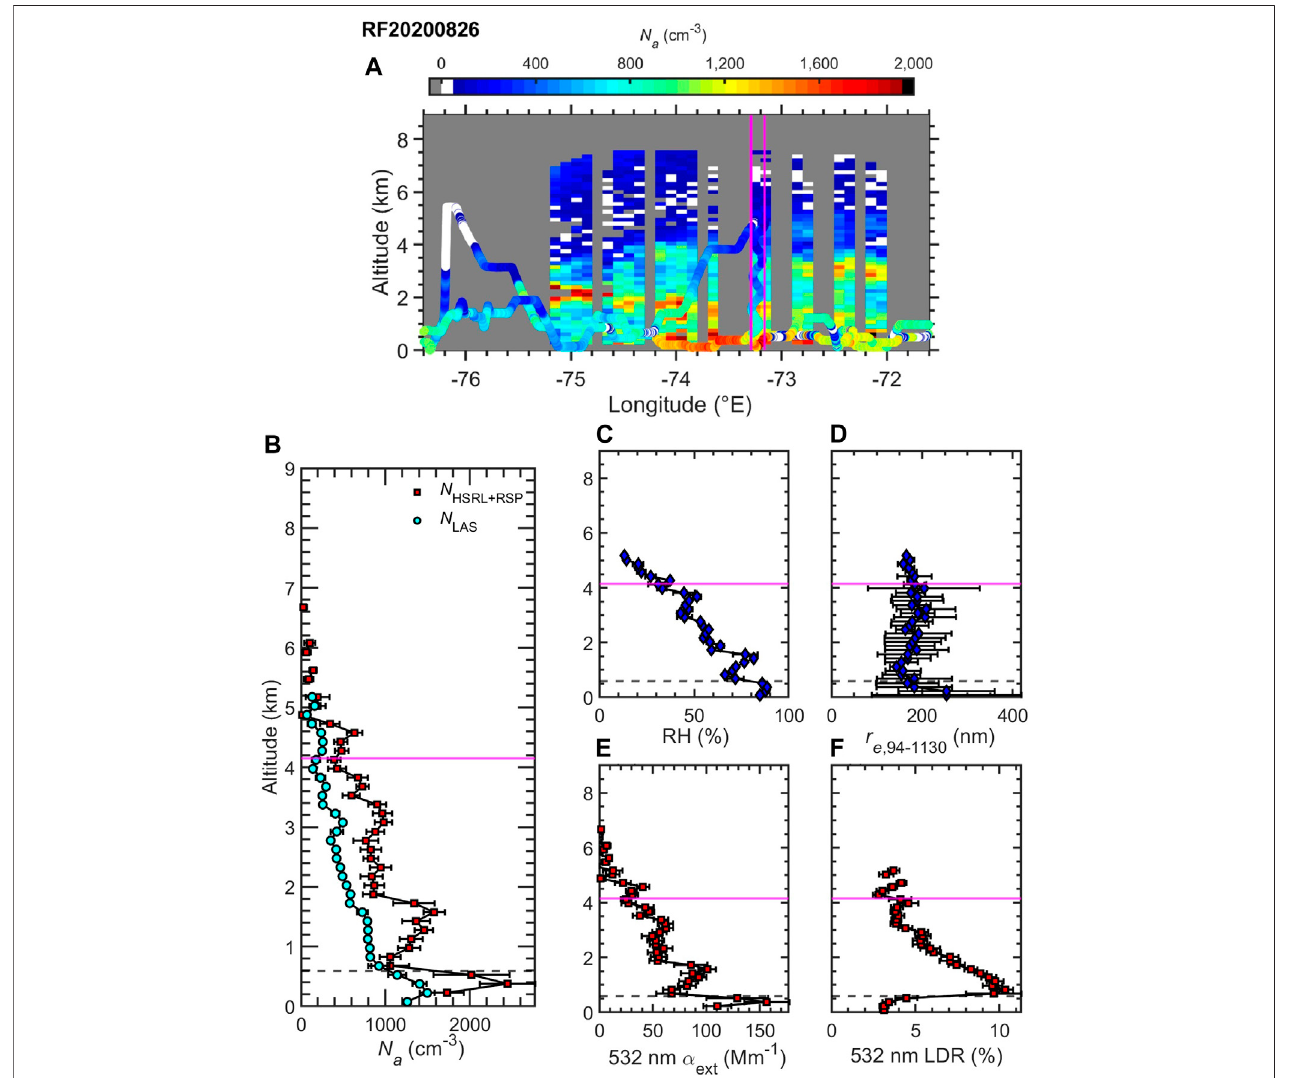
FIGURE 3 | Horizontal curtain (A) and vertical pro fi les (B – F) of remote sensing and in situ data gathered from the ‘ optimal ’ fl ight that occurred on 26 August 2020. The vertical pro fi les were taken from the in situ pro fi le that occurred between 15:46:25 and 15:58:12 (UTC) on 26 August 2020. Panel (A) shows the fl ight track and surface plot colored by N LAS and N HSRL+RSP , respectively, where the magenta vertical lines mark the start and stop locations of the fi rst optimal vertical in situ pro fi le. Panel (B) showverticalpro fi lesofaverageaerosolparticlenumberconcentration(derivedfromthevariousmethods), (C) RH, (D) r e ,94 – 1130 , (E) 532 nm α ext ,and (F) 532 nm LDR; where the whiskers mark ± one standard deviation. The horizontal dashed-black and solid-magenta lines mark the MLH and the ATH, respectively.